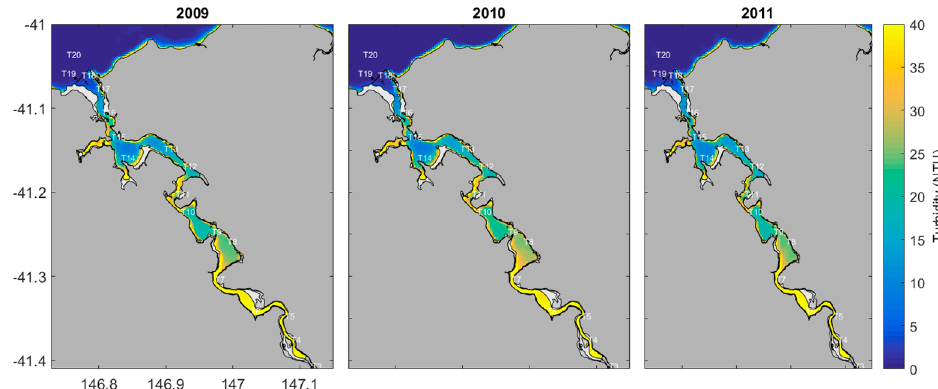
Figure 4. Annual satellite-derived climatology composites of turbidity derived from MODIS Band 1 surface reflectance using coefficients derived from the linear correlation between Band 1 surface reflectance and in situ measurements using equation y = 0.1136x − 5.5956 from a combination of images ( n = 114) that had the highest correlation with in situ values.